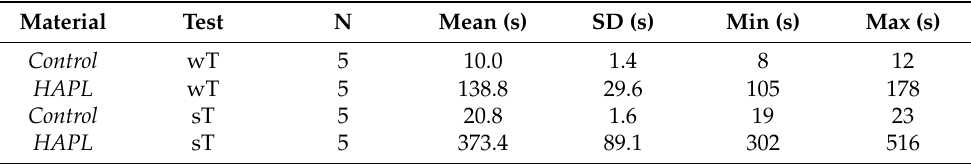
Table 1. Descriptive statistics. Time in seconds (s) corresponding to the hydrogels’ working and setting